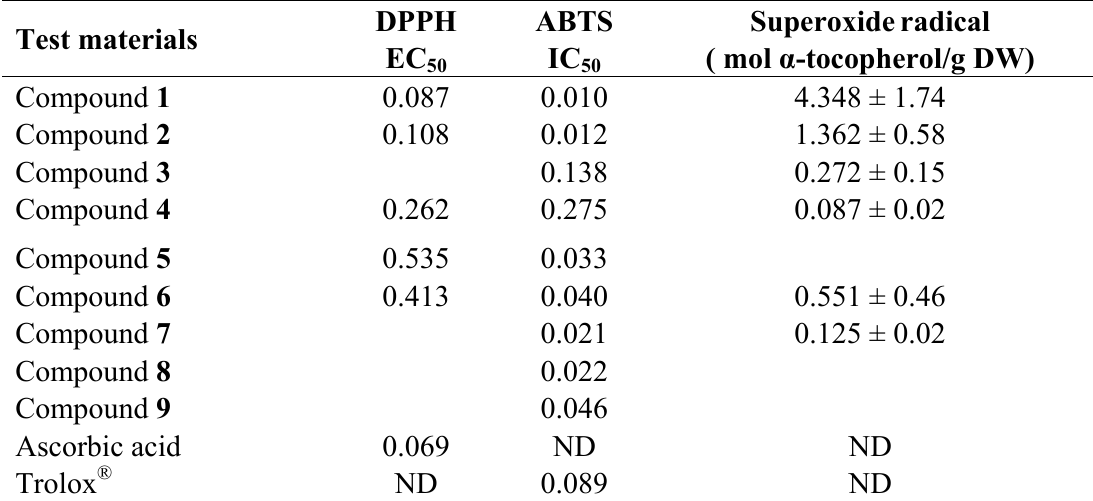
Table 3. The DPPH, ABTS + and Superoxide anion radical-scavenging capacities of the isolated compounds from D. cambodiana